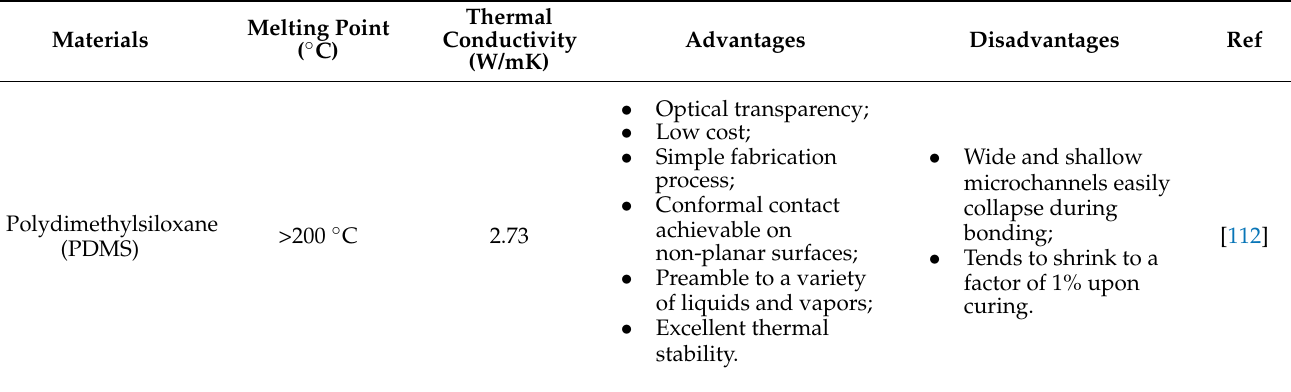
Table 6. Different materials used for the fabrication of microfluidic